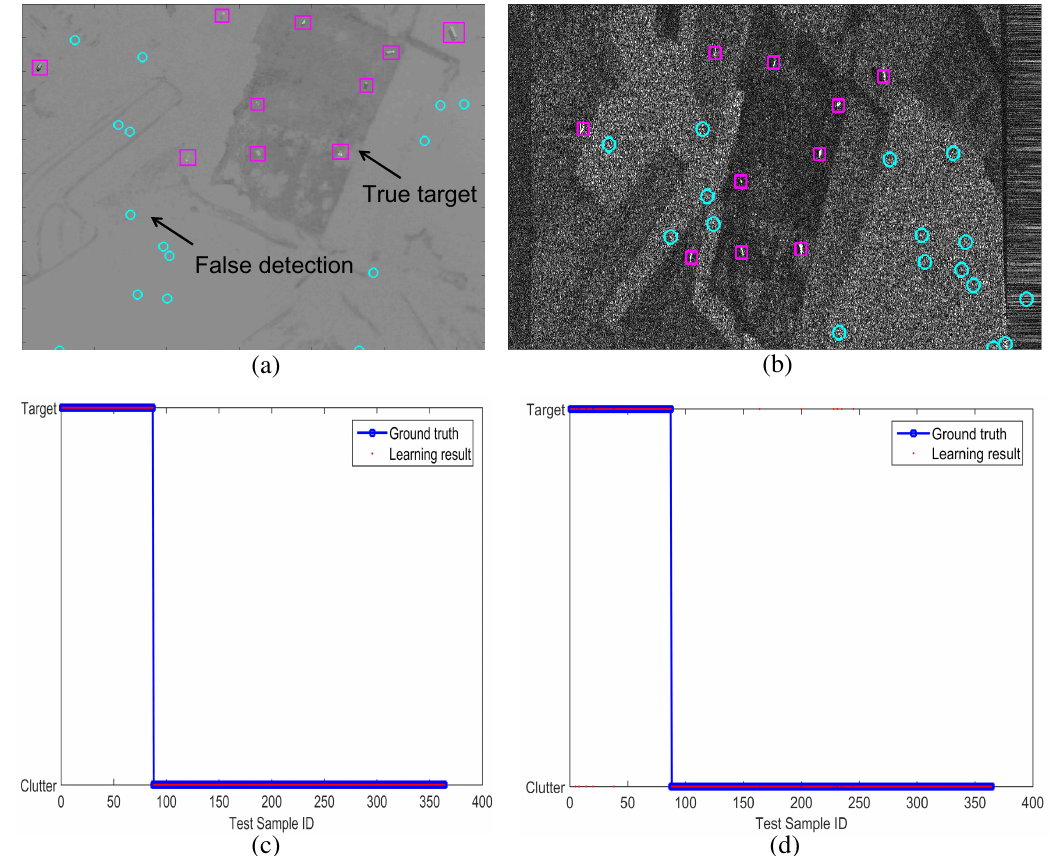
Figure 26. Preparation of training data and trained results: ( a ) true targets and false detections in an IR image (BG1-T10-IR); ( b ) true targets and false detection is an SAR image (BG1-T10-SAR); ( c ) trained results of Adaboost (error rate 0%); ( d ) trained results of LapSVM (error rate